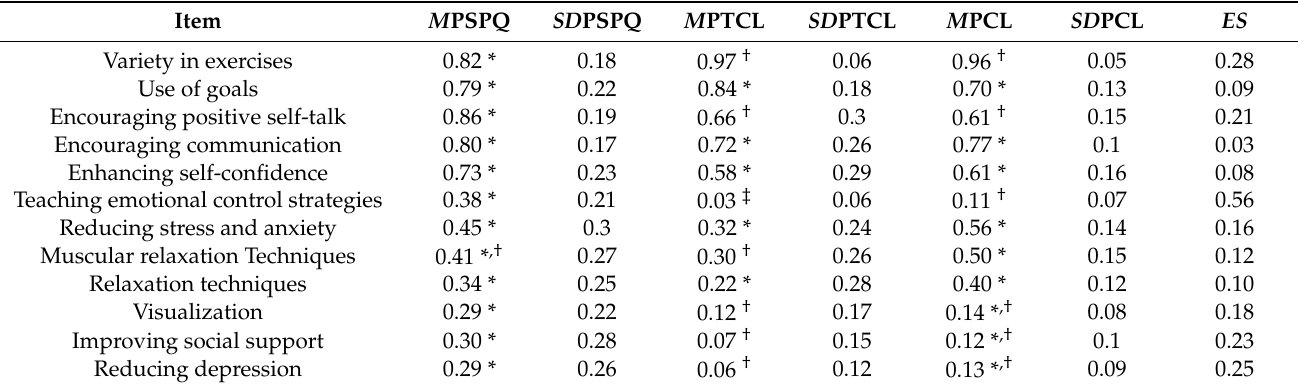
Table 5. Means and standard deviations for physical therapists’ responses to the PSPQ items, physical therapists’ responses to behavioral checklist items, and patients’ responses to the behavioral checklist